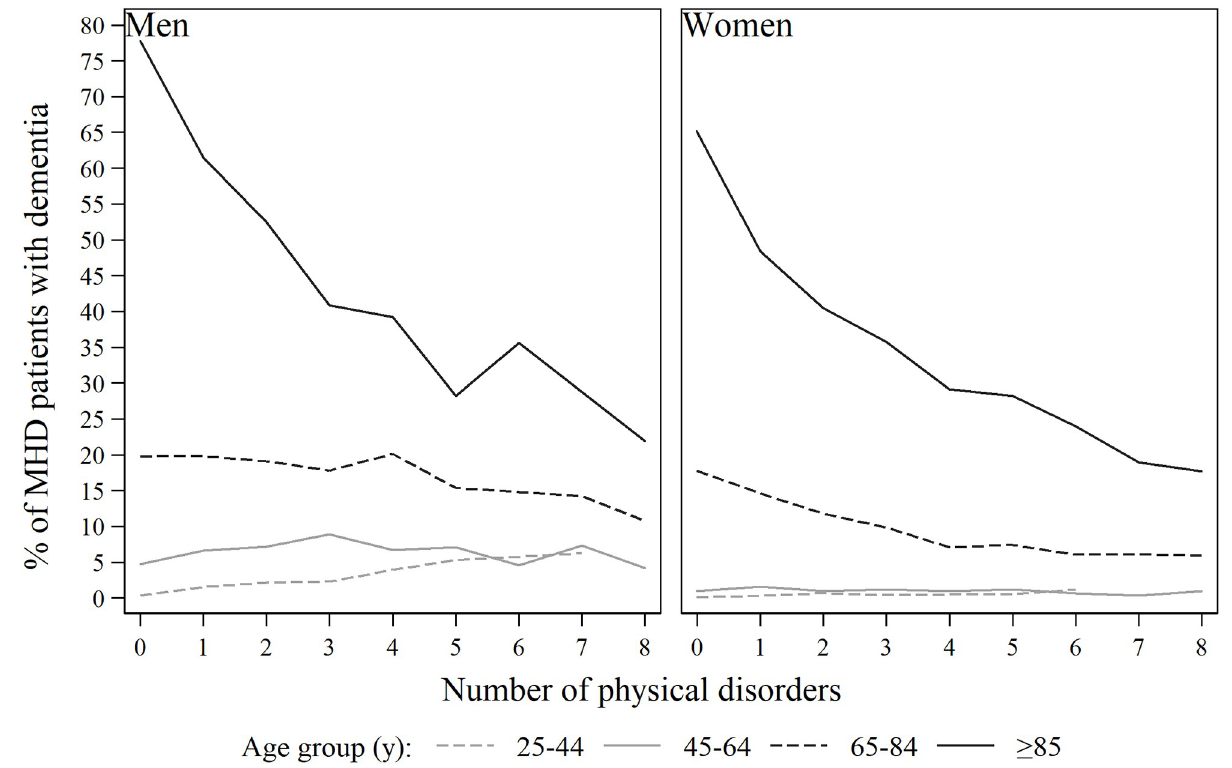
Fig 3. Distribution of patients with dementia by age group and number of physical disorders.